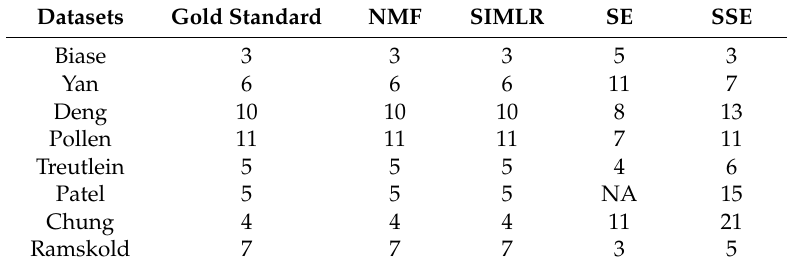
Table 4. The number of clusters in the ‘gold standard’ and four methods.